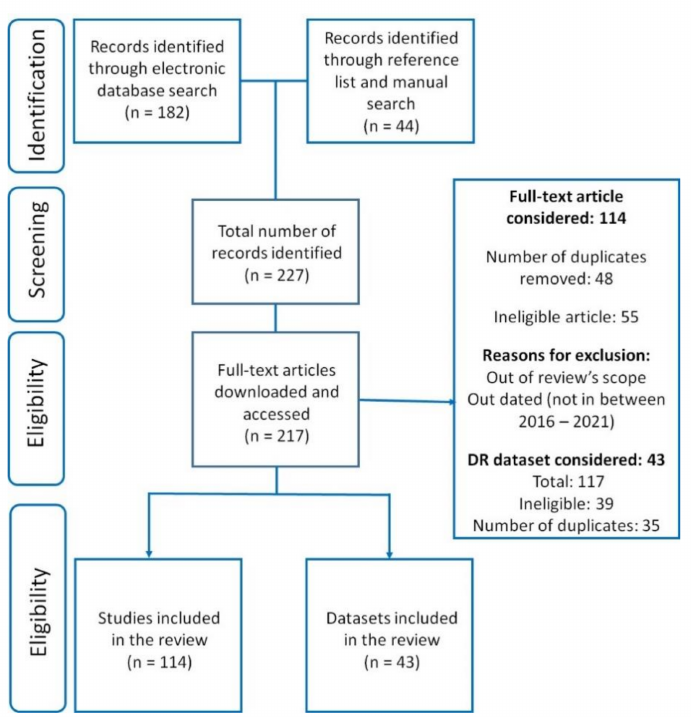
Figure 4. Flowchart summarizing the literature search and dataset identification using PRISMA review strategy for identifying articles related to automated detection and diagnosis of diabetic